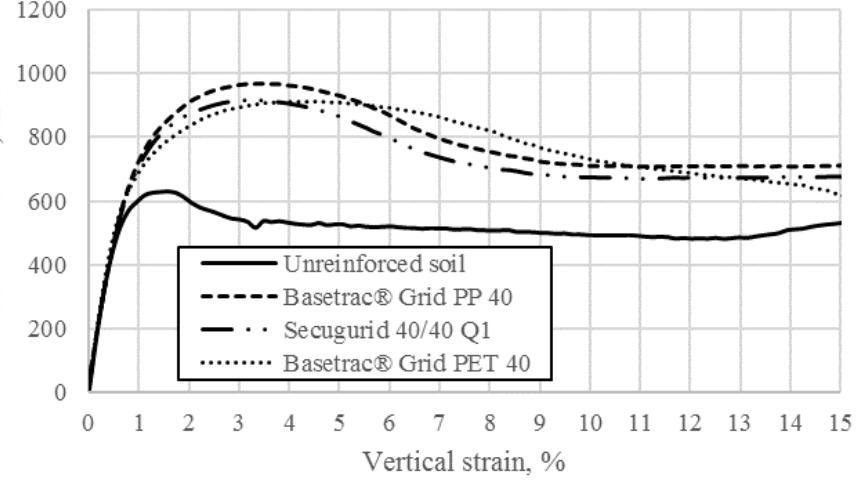
Figure 5: Dependence of stress deviator on the vertical strain of unreinforced and reinforced soil samples with geogrids when the cell pressure σ = 200 3